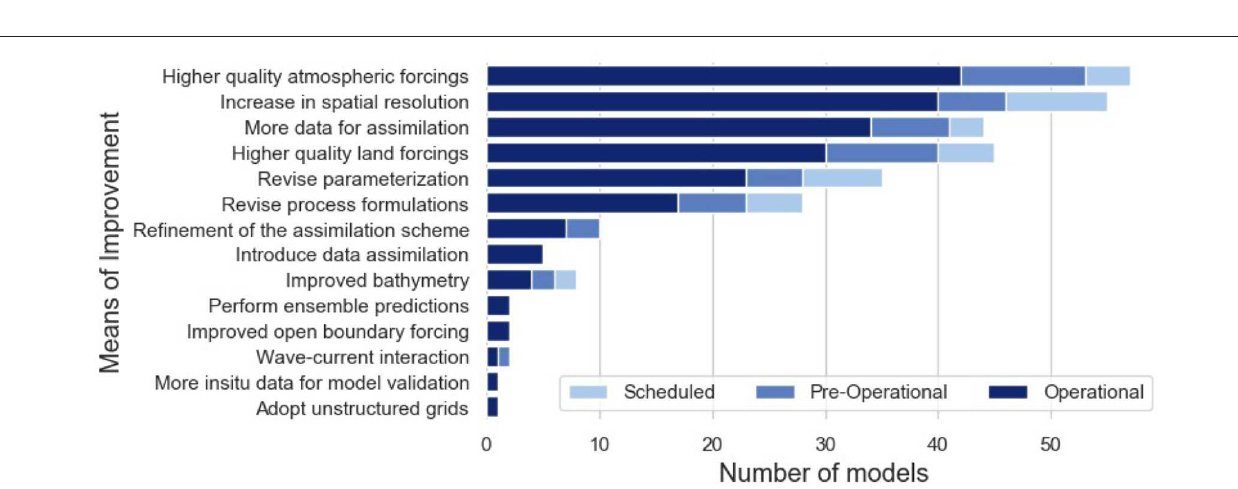
Frontiers in Marine Science |